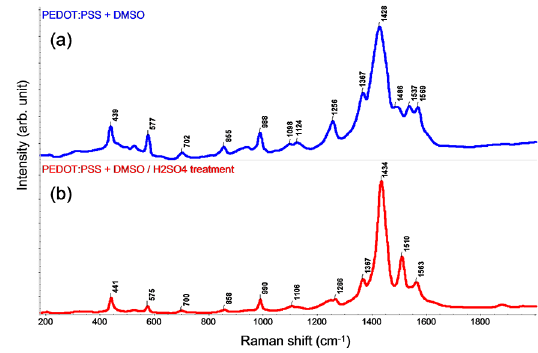
Figue 4. Raman spectra of (a) untreated PEDOT:PSS+DMSO and (b) sulfuric acid treated PEDOT:PSS+DMSO tri-layer films